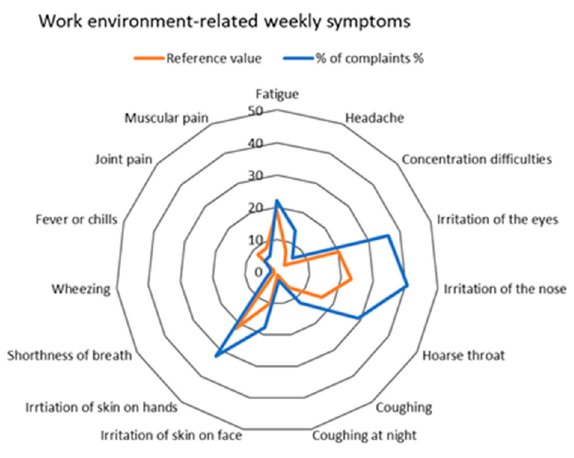
Figure 2. In the buildings assessed for probability of abnormal IA exposure, weekly work environment-related symptoms (n = 1558) were perceived more often than in the Finnish Institute of Occupational Health’s (FIOH) comparable reference data [28].